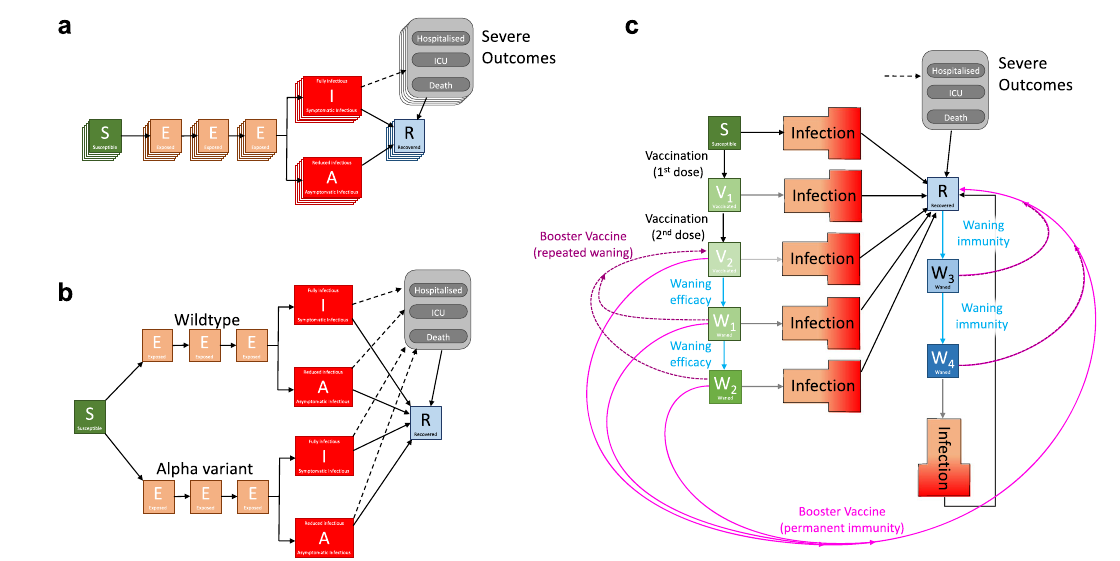
Fig. 9 | Caricatures of the development of the Warwick SARS-CoV-2 transmis- sion and COVID-19 disease model. a The basic SEIR -type structure of the model, with three exposed classes, infectious individuals partitioned into symptomatic ( I ) andasymptomatic( A ),andwithsevereoutcomesdrivenbysymptomaticcases;the multiple layers represent age-structure. b The inclusion of an extra variant